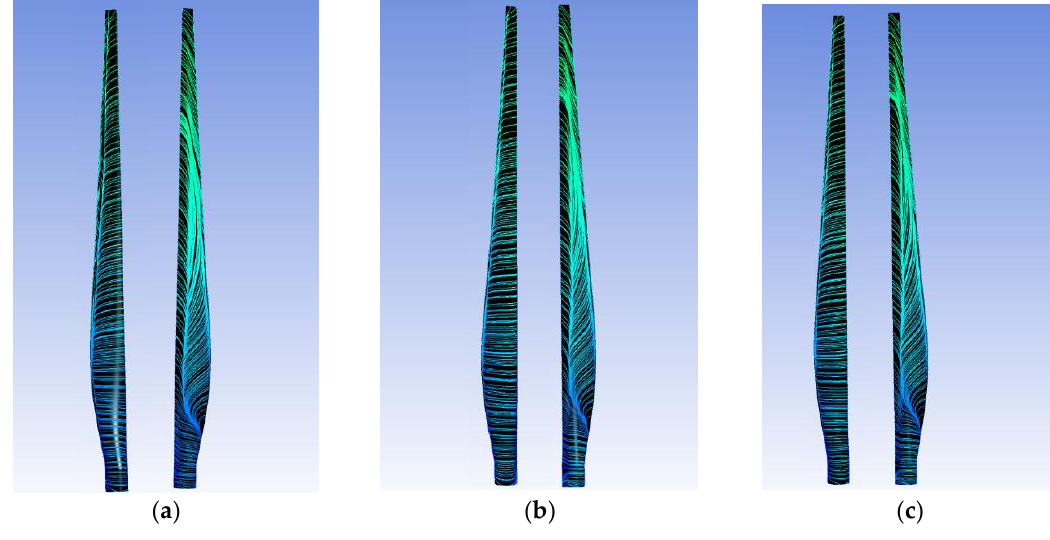
Figure 8. Streamlines on blade surface in the absence of bumps. ( a ) When 𝜆 = 1.83 ( b ) When 𝜆 = 2.93 ( c ) When 𝜆 = 3.26 .